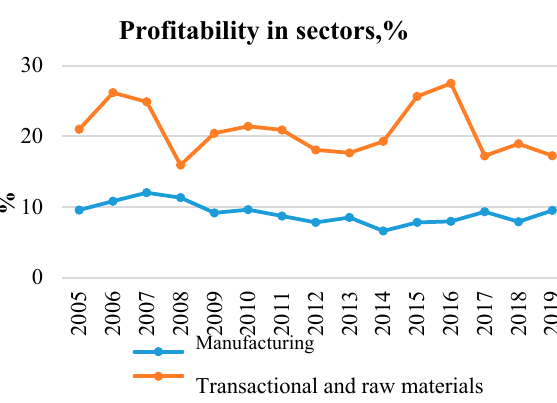
Figure 10. Risk (above), profitability (below) by sector in the Russian economy, 2005–2019 8 . Figure 10. Risk ( above ), profitability ( below ) by sector in the Russian economy, 2005–2019 8